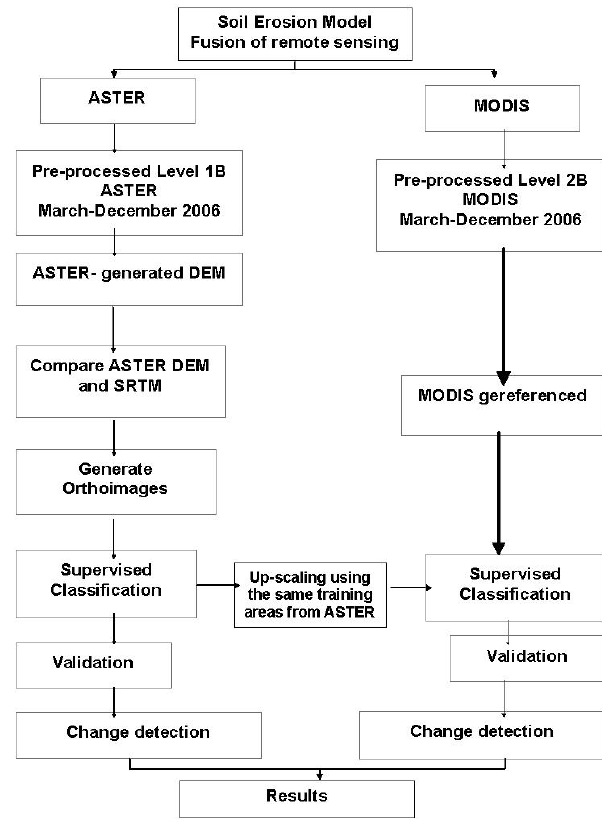
Figure 3 Flow diagram summarising the methodology. On the left hand side are the steps involved using ASTER and On the right hand side are those involving MODIS. The change in area of eroded land between March and December 2006 is calculated on both MODIS and ASTER scales